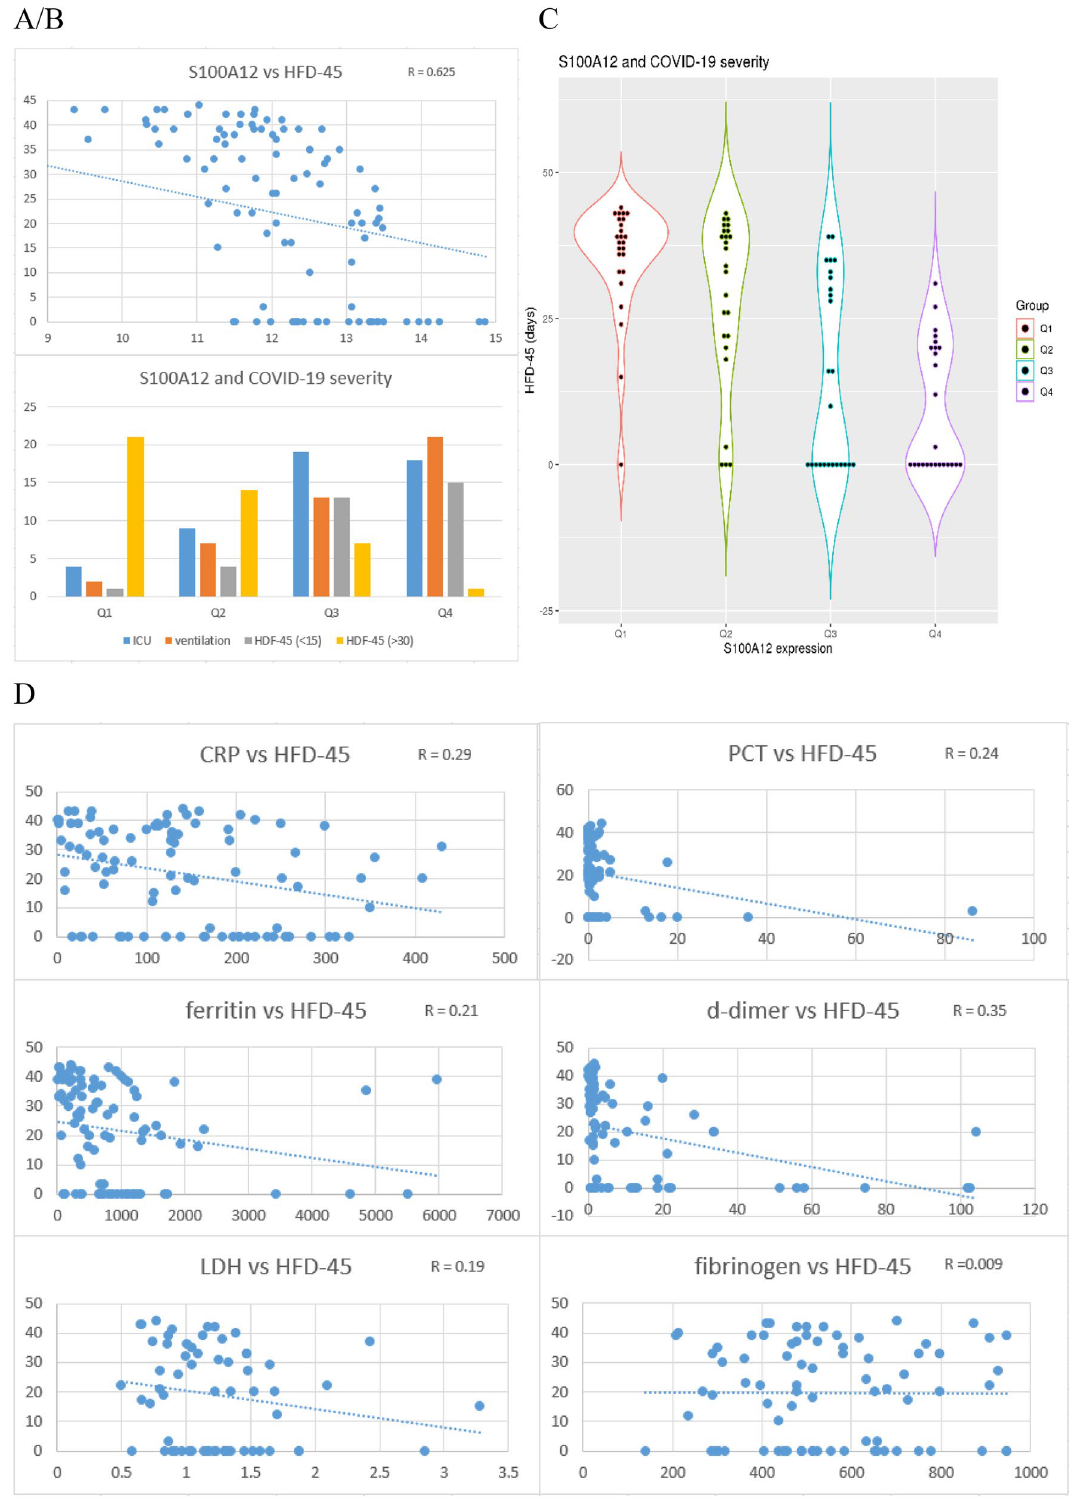
Figure 5. S100A12 expression highly correlated with future disease severity in COVID-19 patients. ( A ) upper left, scatter plot, correlation of S100A12 expression with severity index HFD-45 in COVID-19 patients. ( B ) upper left, histogram plot, comparison of severity indexes in four groups of COVID-19 patients based on the S100A12 expression. The severity indexes include the status of admission to ICU, use of mechanical ventilation, and small or large HFD-45 values. ( C ) upper right, distribution of HFD-45 scores in four groups of COVID-19 patients based on the S100A12 expression. ( D ) lower panel, correlation of established markers with